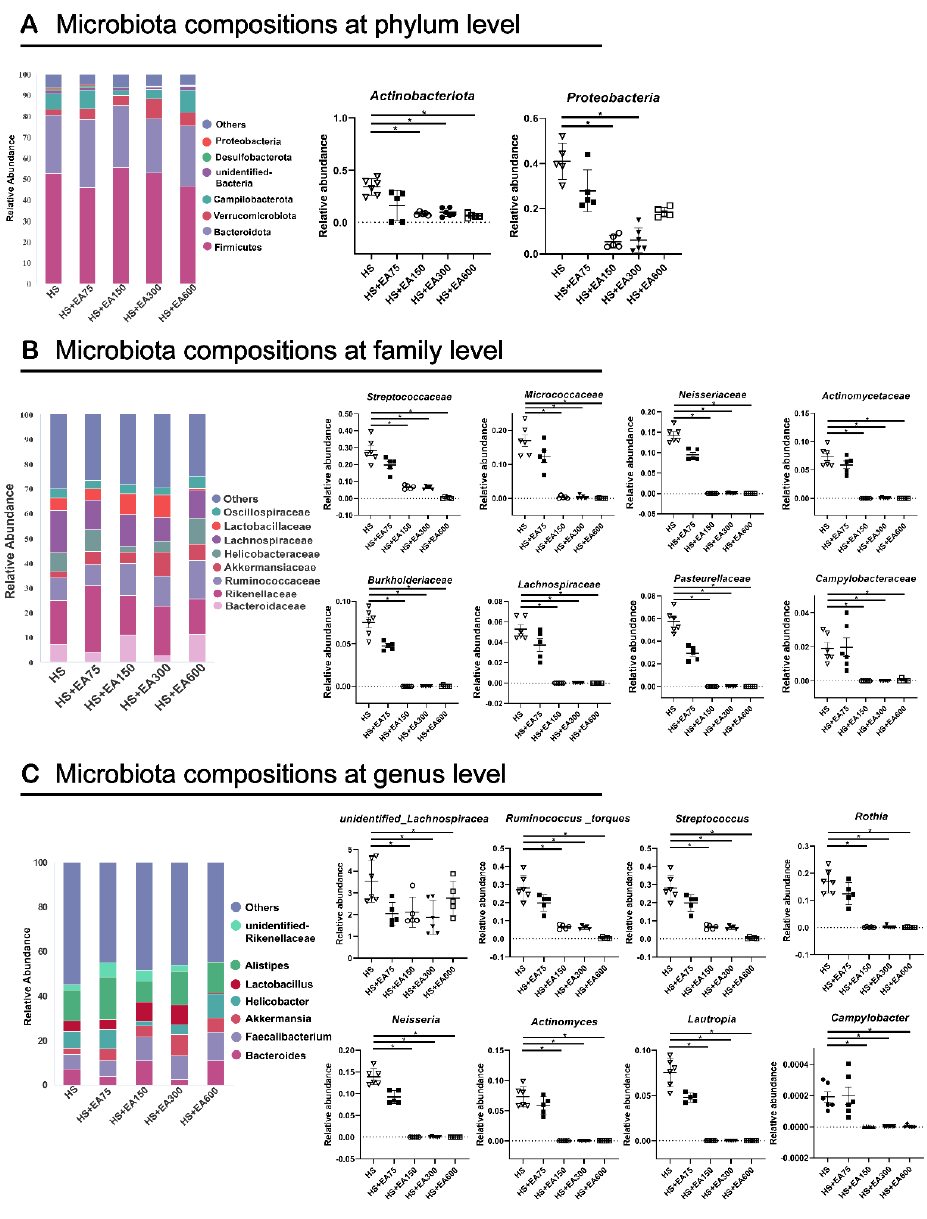
Figure 9. Effects of different levels of EA on cecum microbiota composition at phylum, family, and genus level of heat-stressed broilers. ( A ) Cecum microbiota composition at phylum level; ( B ) Cecum microbiota composition at family level; ( C ) Cecum microbiota composition at genus level; The broilers in the 5 experimental groups were supplemented with basal diets containing different levels of EA (0, 75, 150, 300, and 600 mg/kg) at HS temperature (35 ± 2 °C), which are represented as HS, HS + EA75, HS + EA150, HS + EA300, and HS + EA600, respectively. “ * ” indicates a significant difference between groups where p < 0.05.